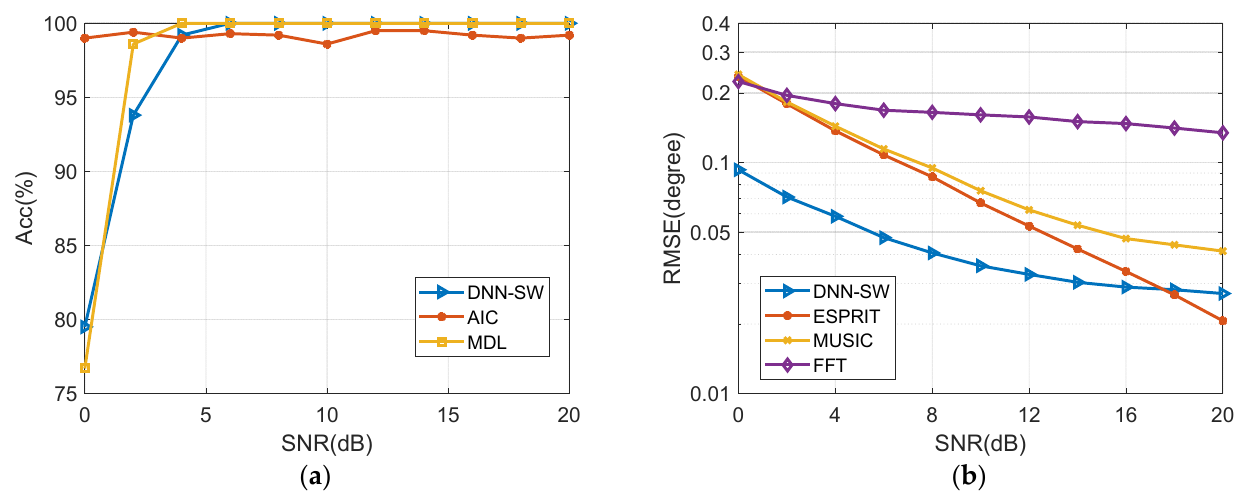
Figure 5. The DOA estimation performance with different SNRs. ( a ) Acc ( b ) RMSE. Moreover, three kinds of array imperfections are considered, including gain inconsistent, phase inconsistent, and position perturbation [14]. It is assumed that the gain-phase inconsistency and position perturbation of different antennas are uniformly distributed within 3 η dB, 30 η ◦ , and 0.15 λη , respectively. η is an imperfect factor to measure the imperfect effect, and it varies from 0 to 1 with the step of 0.1. In this simulation, two sources impinge on this array from the directions of − 6.25 ◦ and 3.18 ◦ . The SNR of these sources is set to 15 dB. For each η , the RMSE is obtained by averaging the results of 1000 MC runs. The results are shown in Figure 6. From (a), it can be observed that the three methods can all estimate the source number accurately. The Acc of DNN-SW is above 99% when η is 0.8 and can reach 92% even η is 1, which means the source number estimation results of DNN-SW are reliable. For MDL and AIC, the results are both satisfying, and they show a similar law to the previous simulation. In this case, the number estimation results of AIC are still considered the basis for DOA estimation comparison methods. (b) gives the RMSE of different methods, and DNN-SW consistently performs better than other methods when the error increases. The results show that the deep learning method is more robust for array imperfections because it has the capability of adaptively learning detailed information from the input data. ( a )